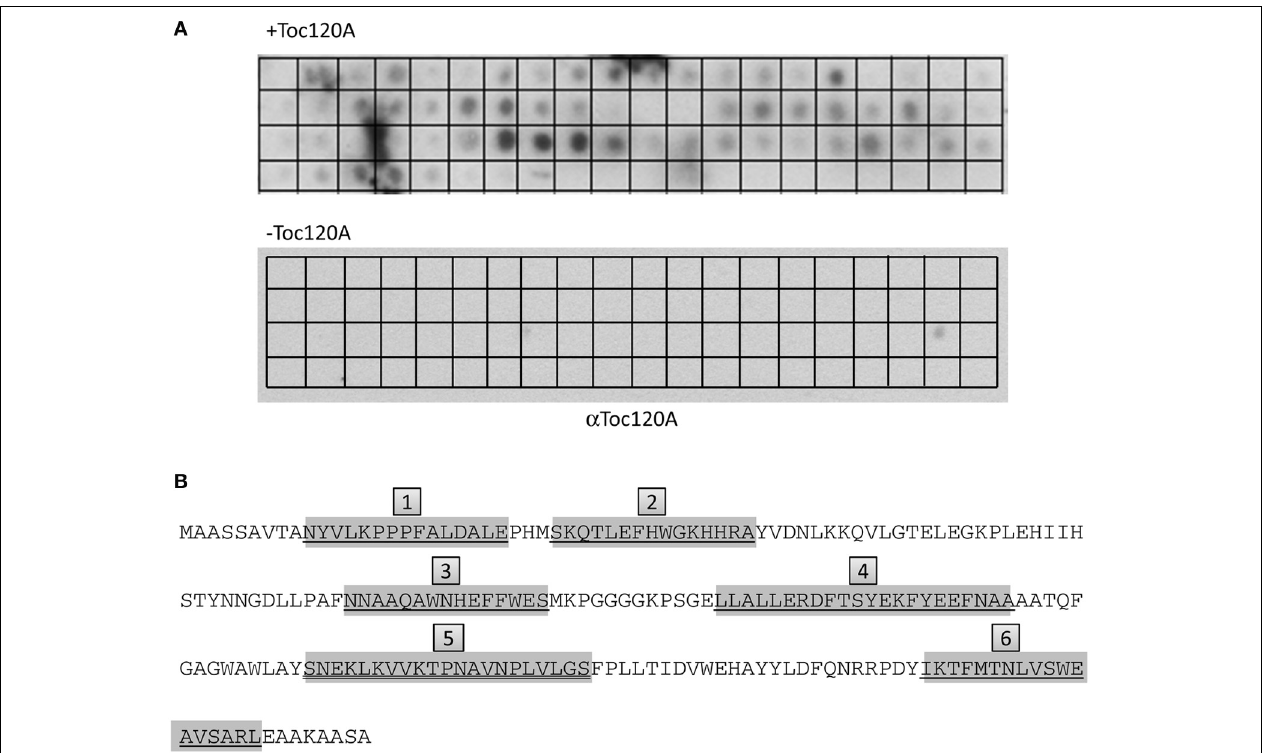
FIGURE 10 | psToc120A domain has specific recognition motifs in FSD1. PepSpot assays were designed and spotted onto filter paper where each peptide represents consecutively 15 AA with an overlap of 12 AA. In total, 67 peptides were spotted; the last 13 spots of the membrane are devoid of peptide. (A) Heterologously